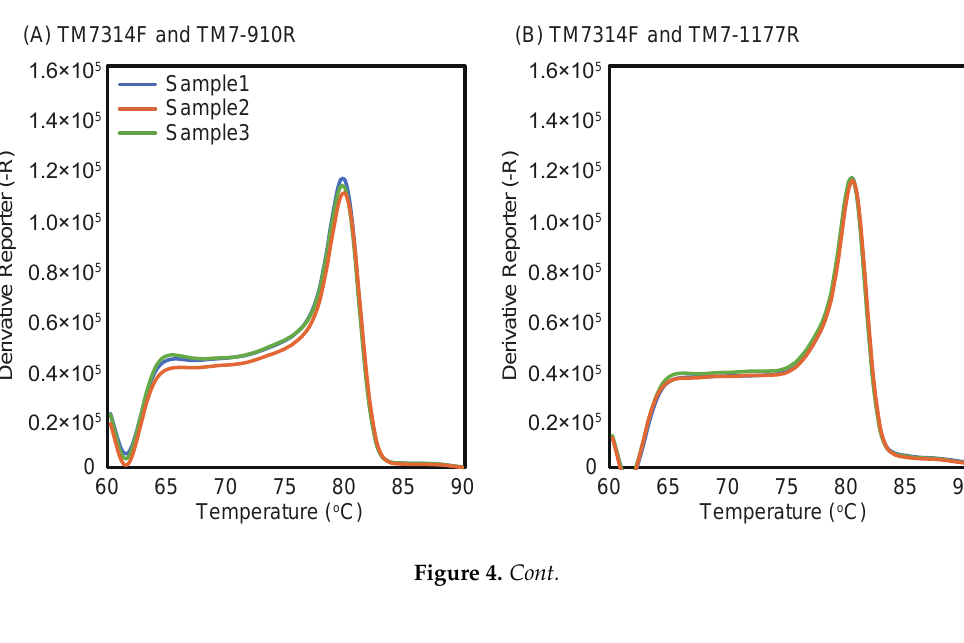
1 Figure 4. Melting curves of qPCR reactions using activated sludge samples and the four primer sets: TM7314F and TM7-910R ( A ); TM7314F and TM7-1177R ( B ); TM7580F and TM7-910R ( C ); and TM7580F and TM7-1177R ( D ).